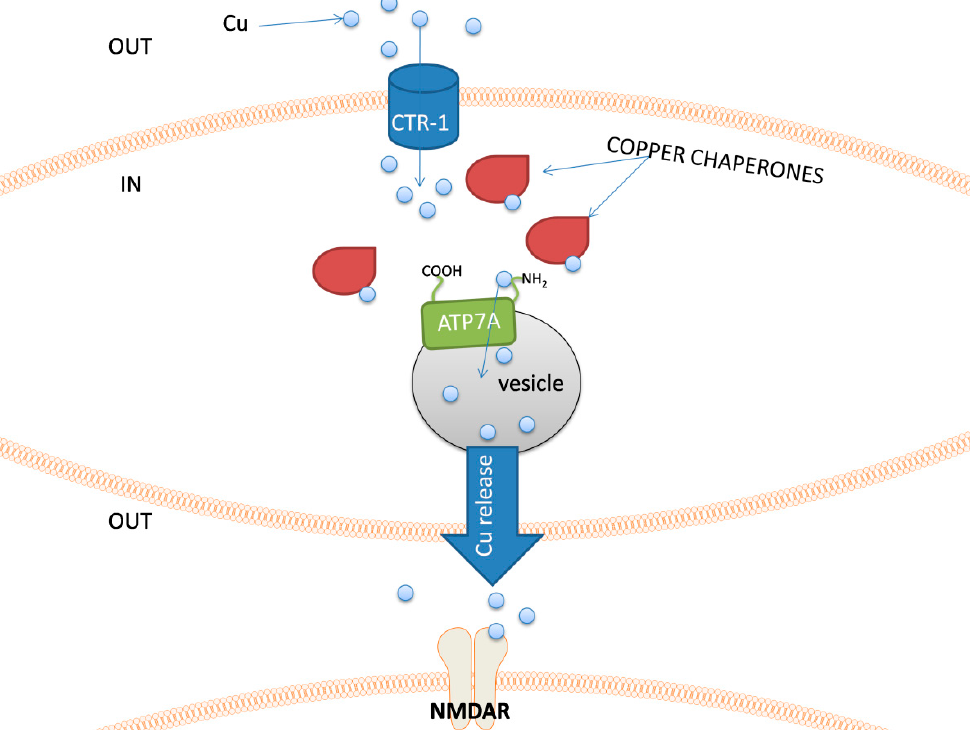
Figure 4. The schematic representation of an example sequence of events related to copper release possible in nerve cells. Copper ions are taken up to the cell by a Cu transporter 1 (CTR ‐ 1). The presence of free Cu + ions immediately activates a set of copper chaperones. These proteins transport copper within the cell and deliver it to its destination. In neurons, that can release copper into the synaptic cleft, chaperones introduce copper ions to the ATP7A protein, which transport it to the lumen of a vesicle. After Cu release, it can interact with e.g.,